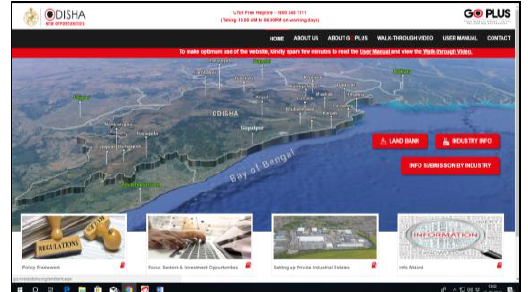
Figure 2. Landing Page design of the